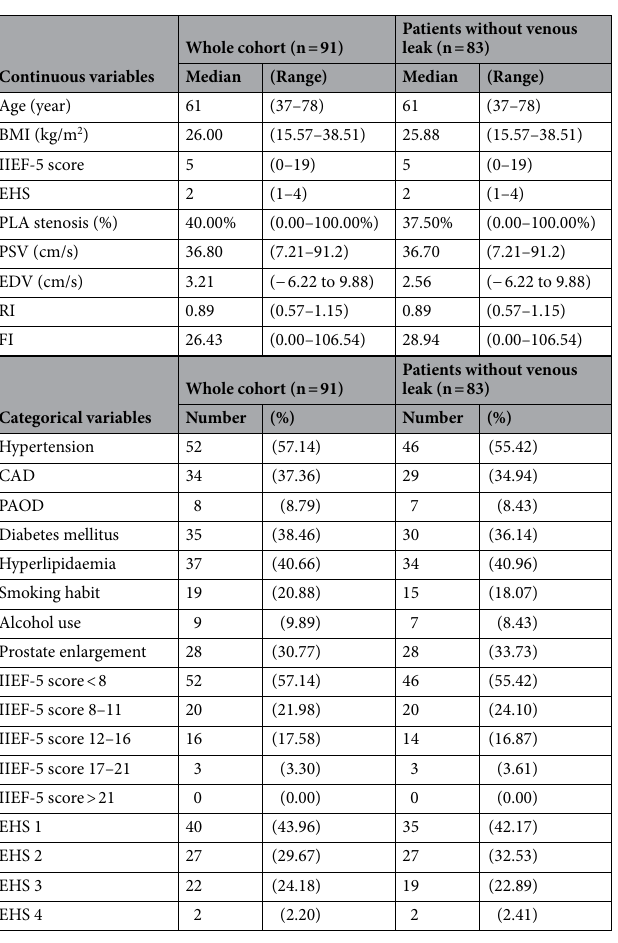
Table 1. Characteristics of the enrolled population. Median PSV and RI were within normal reference, while more than half of patients had IIEF < 8 or EHS < 3. BMI body mass index, CAD coronary artery disease, EDV end-diastolic velocity, EHS erection hardness score, FI flow index, IIEF-5 the simplified International Index of Erectile Function, PAOD peripheral arterial occlusive disease, PLA pelvic artery, PSV peak systolic velocity, RI resistance